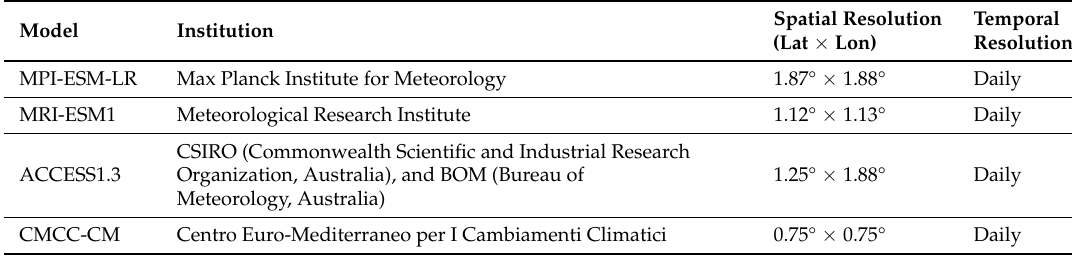
Table 1. Model acronym, institution, and atmospheric